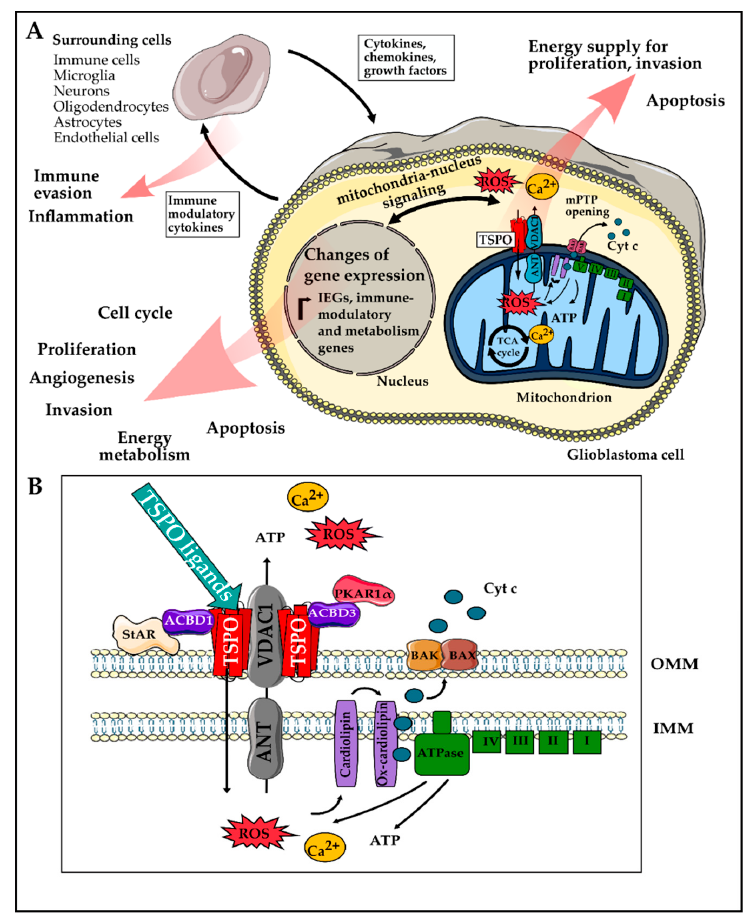
Figure 2. Overview of the mechanisms of how TSPO could modulate the hallmarks of Glioblastoma (GBM). ( A ) TSPO, together with other mitochondrial proteins such as voltage-dependent anion channel (VDAC), adenine nucleotide transporter (ANT), and ATPase can modulate mitochondrial Ca 2+ release of cyt c, which triggers the mitochondrial apoptosis cascade and ultimately apoptosis. An